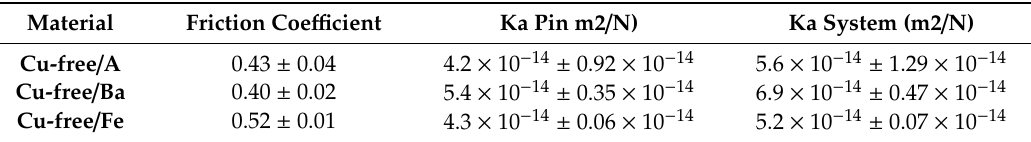
Table 2. Average values of friction coefficient (µ) at steady-state and experimental specific wear coefficients (K a ).